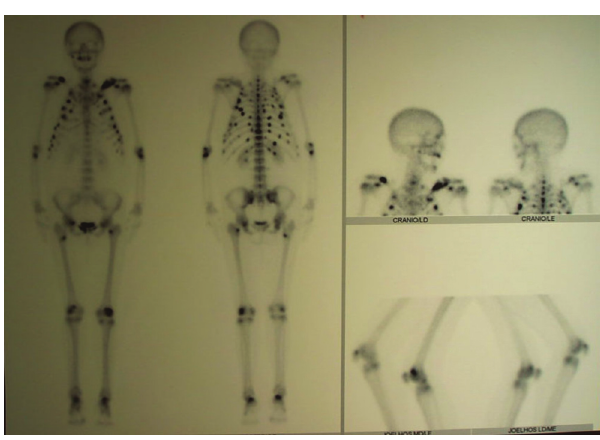
Figure 1 - Bone scintigraphy on patient: multiple areas of osteogenic